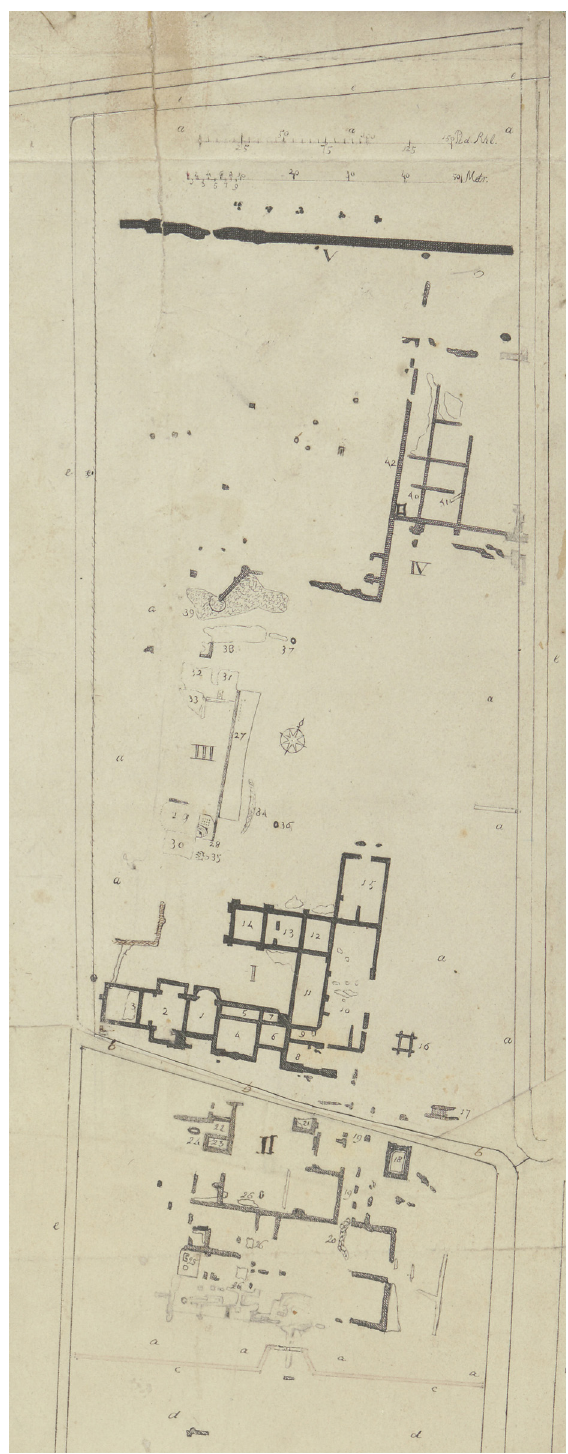
Figure 5: Part ofthe originalexcavation plan, with annotations. Courtesy of the NationalMuseumof Antiquities, Leiden [ RA 30 c b ]